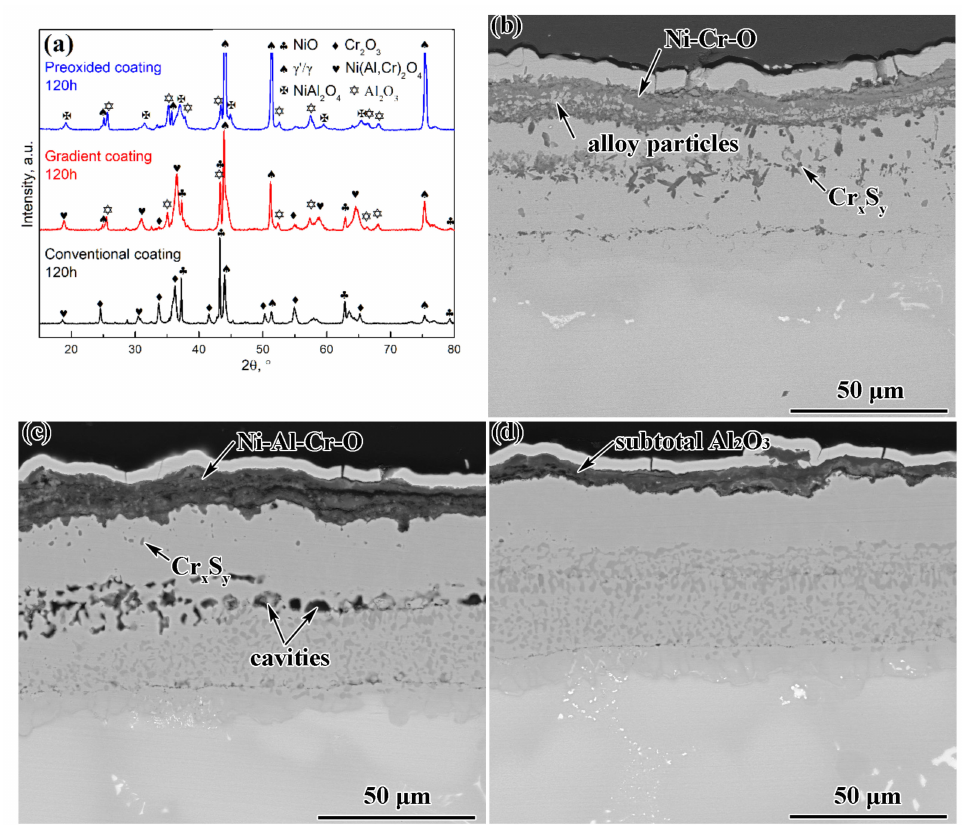
Figure 7. Surface XRD curves and cross-sectional BSE images of the three coatings after the hot corrosion test lasting 120 h: ( a ) XRD patterns of the three coatings; ( b ) the conventional coating; ( c ) the gradient coating; ( d ) the preoxidised